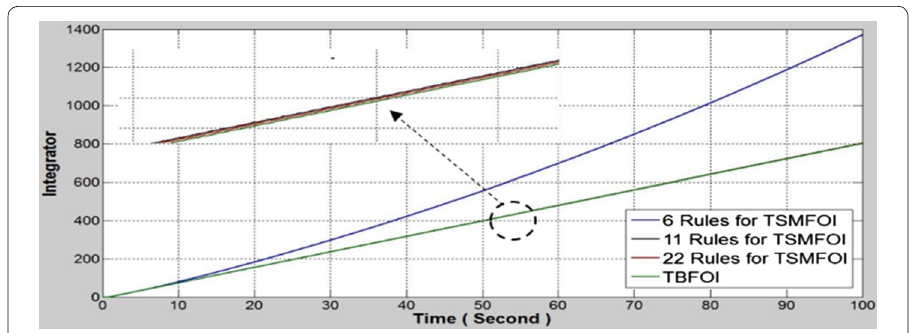
Fig. 9 Step dynamic response of TSMFOI and TBFOI